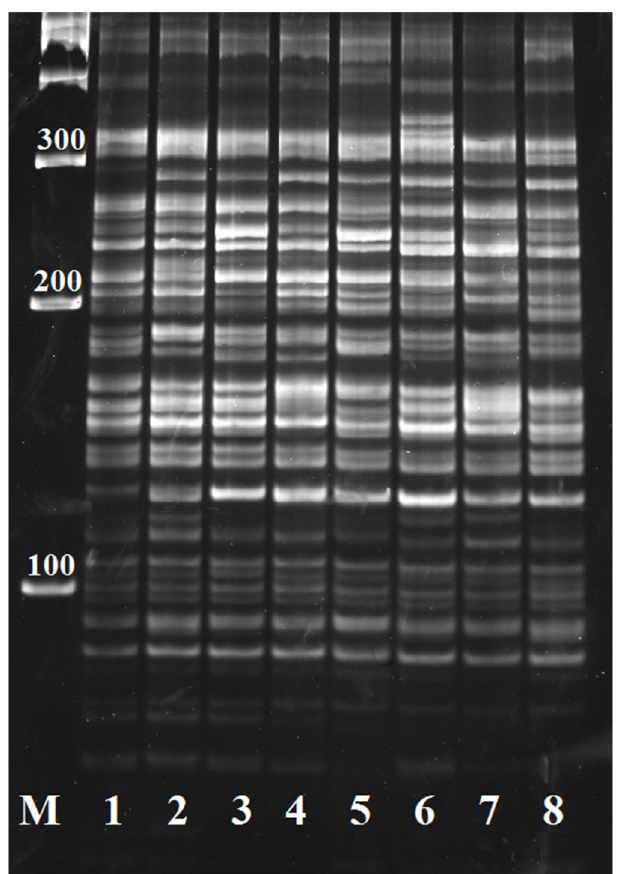
Figure 1. Electropherogram of AFLP fragments produced through the analysis of eight carrot accessions with the primer combination P ‐ AAT/M ‐ CAA showing the highest PIC value (0.41); Berlicum St (1);—Berlicum St (2); Chantenay Coeur Rouge (3); Colmar a Coeur Rouge (4); Purple Dragon (5);—Gelber Goliath (6);—Saint Valery (7);—Deep Purple F1 (8); GeneRuler100 bp plus DNA ladder (M).